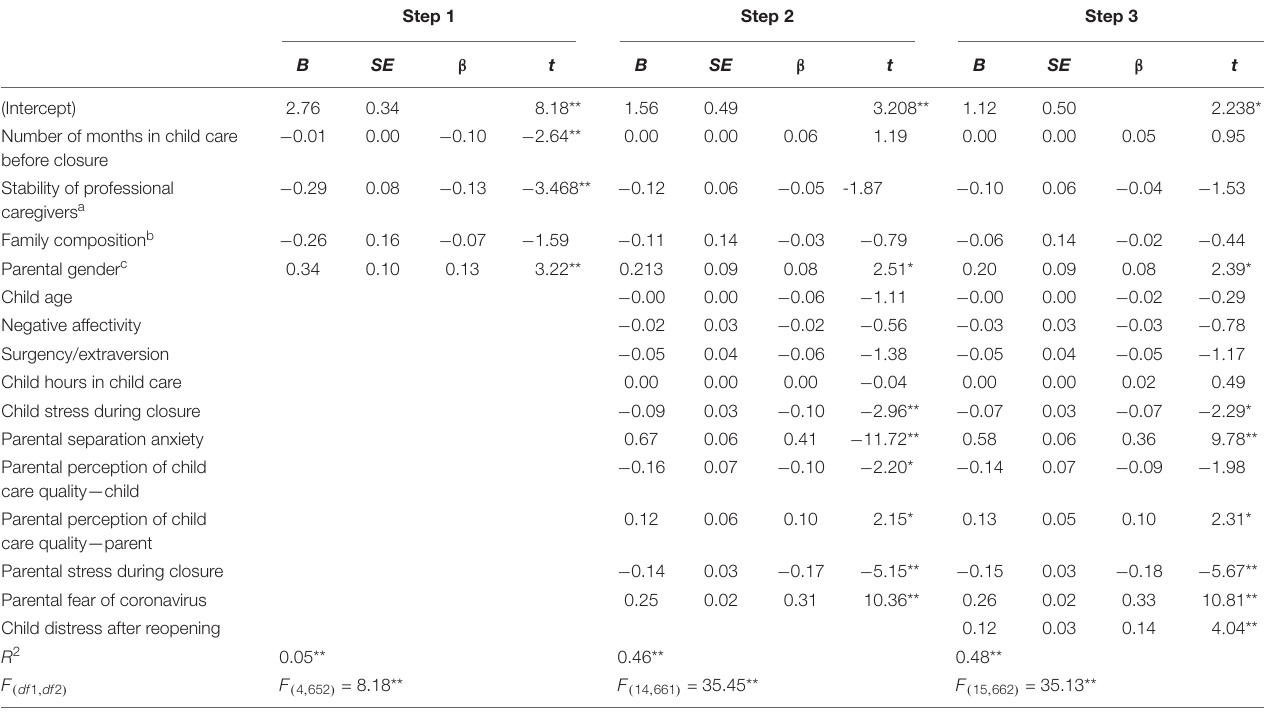
TABLE 4 | Results of the hierarchical multiple linear regression analysis predicting parental distress after reopening ( N = 694). Step